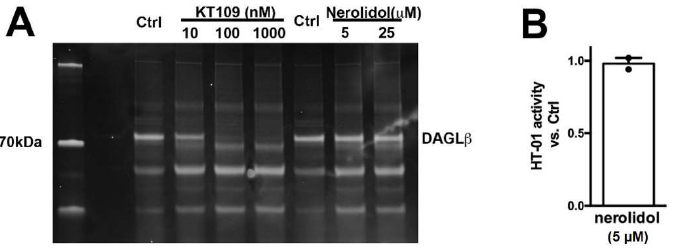
Figure 5. Nerolidol does not compete for binding at the active site of DAGLβ. ( A ) DAGL-binding probe HT-01 is competed by DAGLβ blocker KT109 (100 nM) but not by nerolidol. ( B ) Summary of results from 2 experiments. NS by one tailed t -test vs. 1.0 (1.0 = no